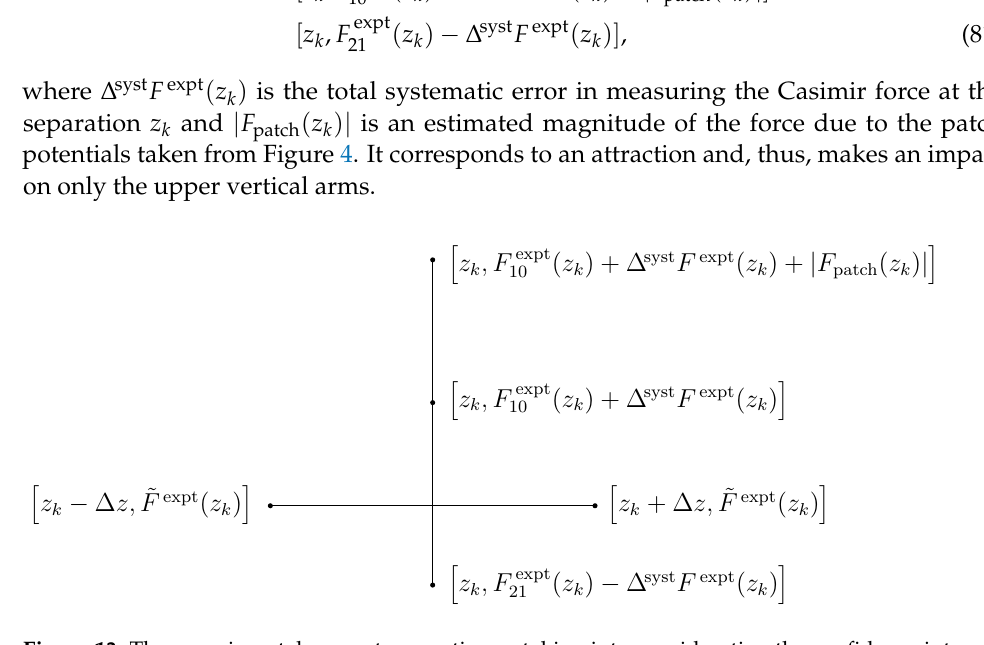
Figure 13. The experimental cross at separation z k taking into consideration the confidence interval, systematic errors (both determined at the 95% confidence level), and the role of patch